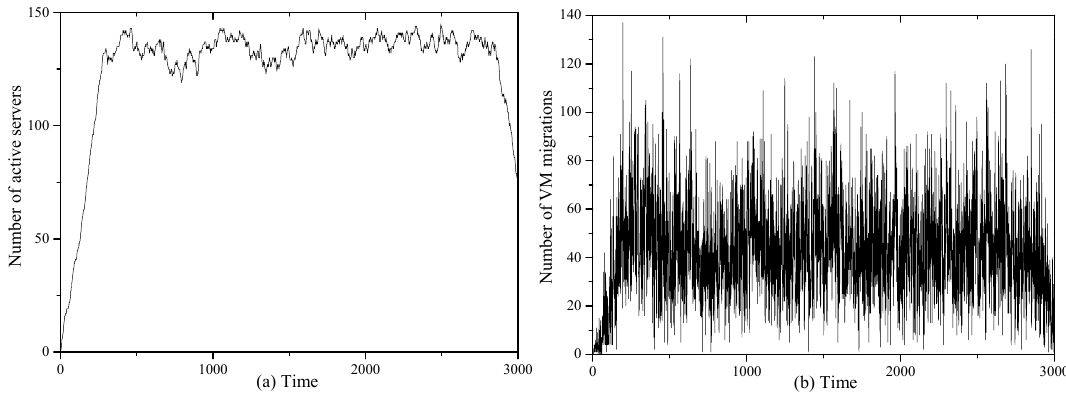
Figure 3. ( a ) Number of active servers; ( b ) Number of VM migrations used by UACS in RW8 during runtime.